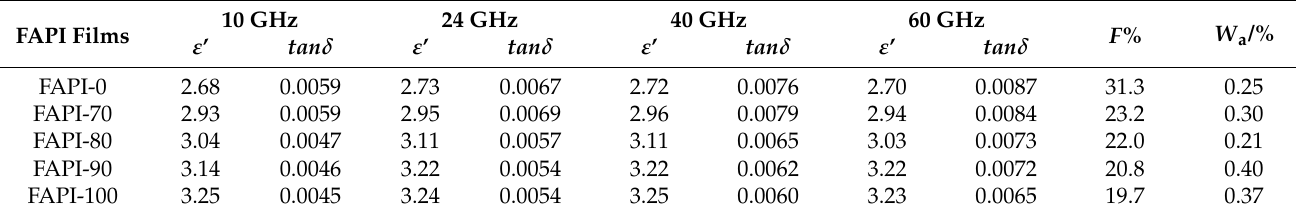
Table 4. Dielectric properties of the FAPI films at high